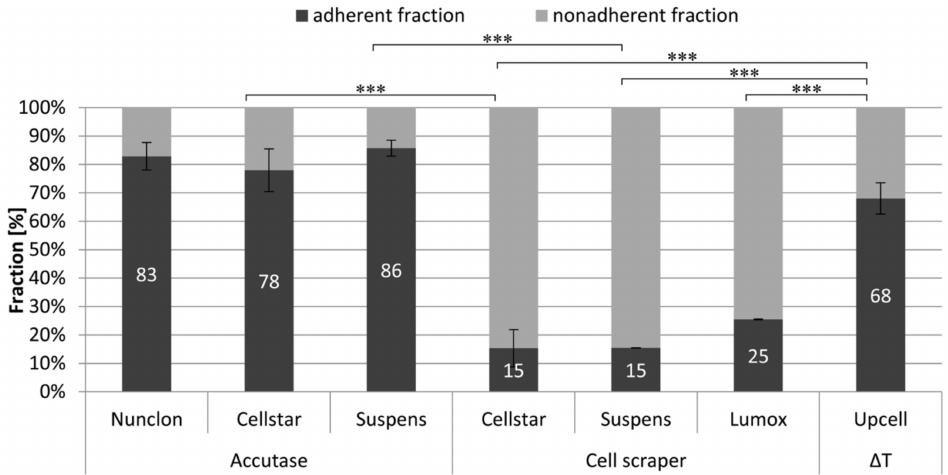
Figure 4. Adherent and non-adherent fraction of mature osteoclasts 1 day after reseeding on Nunclon TM reference plates determined by DNA measurement in lysates (adherent fraction) and supernatants (nonadherent fraction), *** indicate p < 0.001.